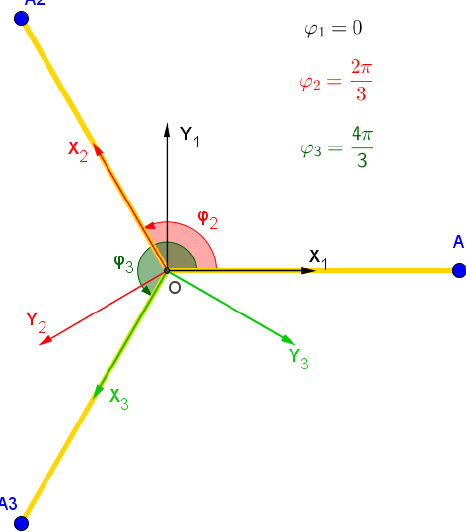
Figure 12. The different coordinates systems, R i